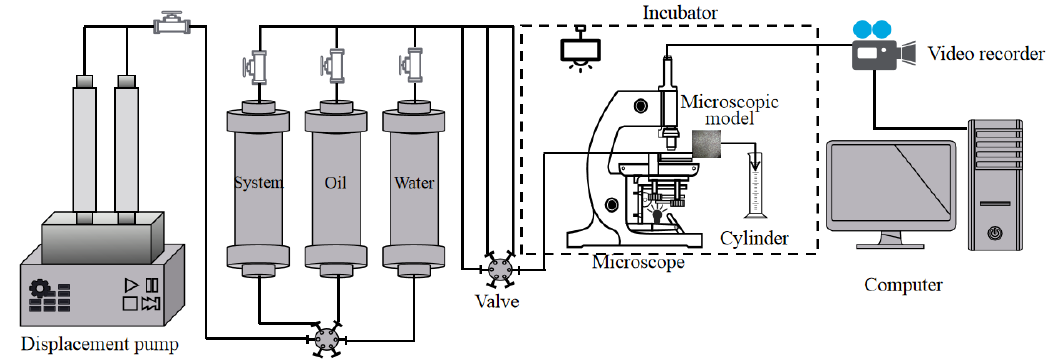
Figure 2. Microscopic visualisation oil displacement device.